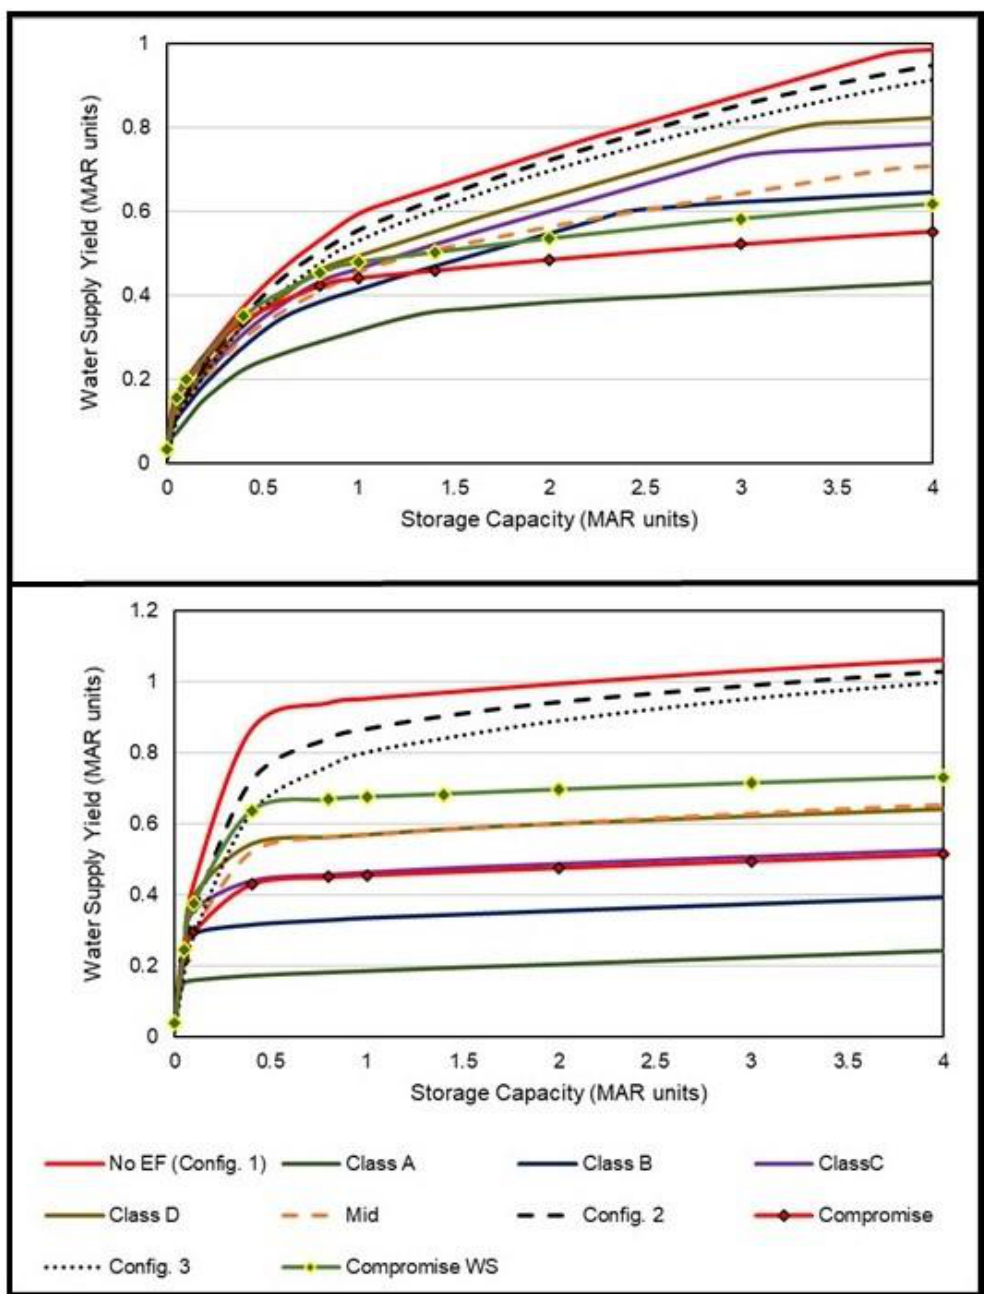
Figure 7. Behavior of WS Yield with storage capacity for different Environmental Management Classes, curves of Mid, Compromise, and Compromise WS, and different scenarios of reservoir system configurations for Malwatu Oya ( top ) and Kalu Ganga ( bottom ).